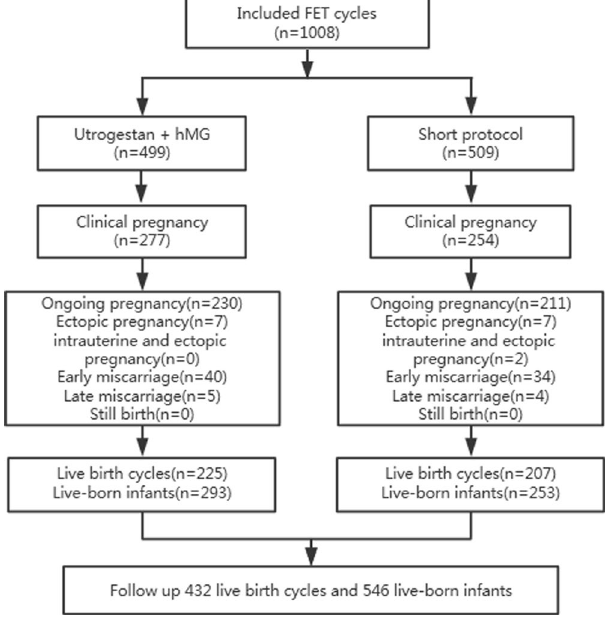
Figure 1. Flowchart of the